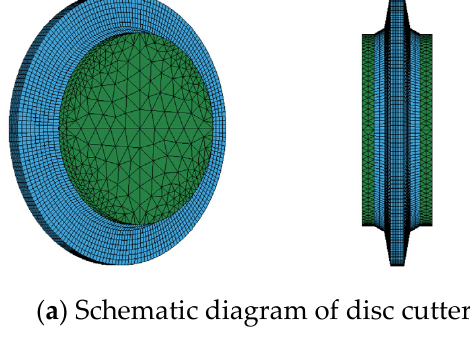
Figure 11. Contact properties between cutter and rock.